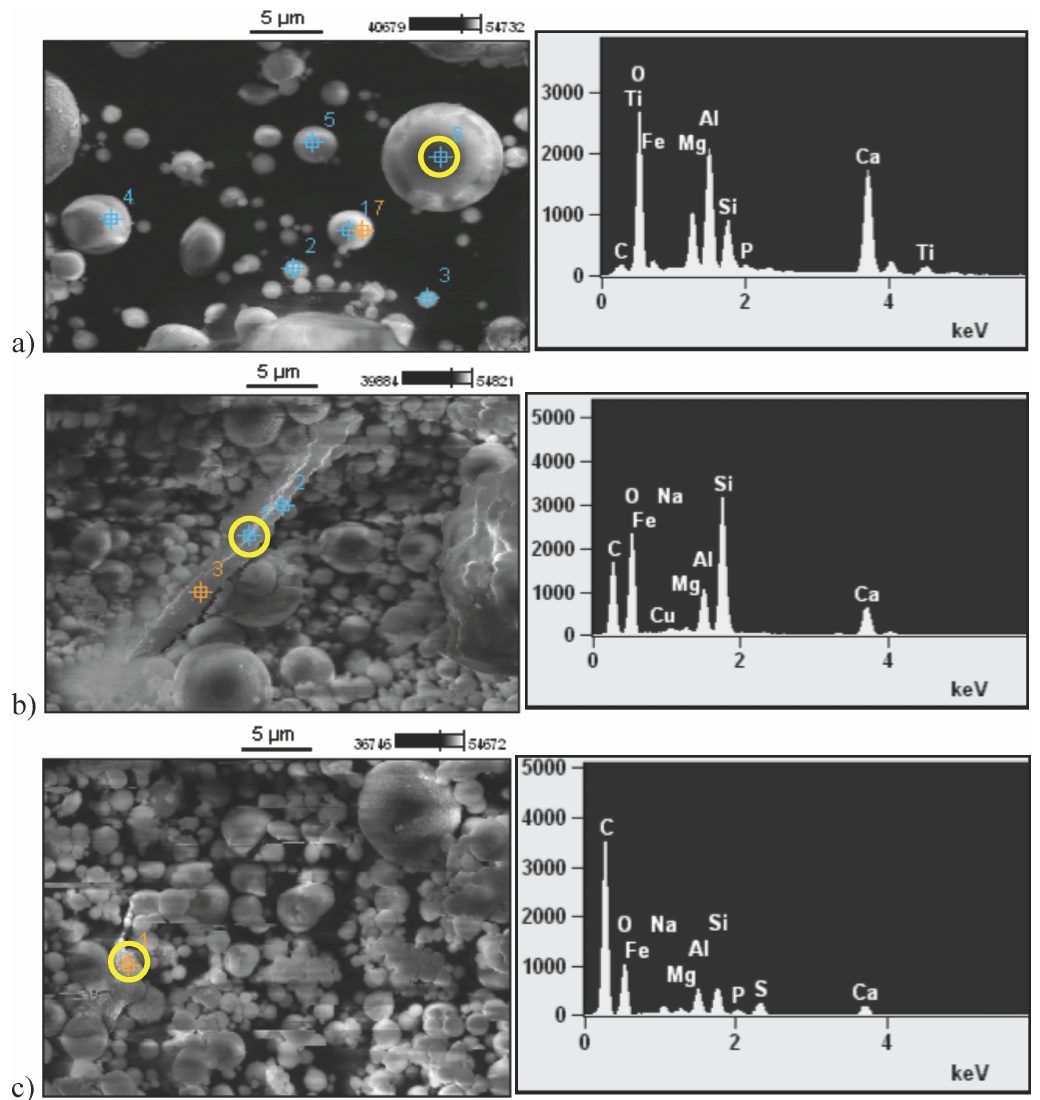
Figure 2. Scanning electron microscopy (SEM) images with corresponding X-ray spectroscopy (EDS) spectra: ( a ) control; ( b ) 10 min; ( c ) 30 min. Point in the yellow circle corresponds to the respective EDS